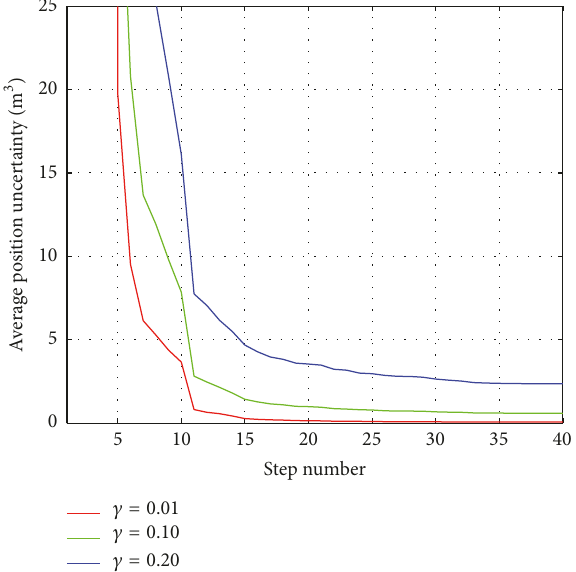
Figure 9: Average landmark uncertainty under different 𝛾 values.